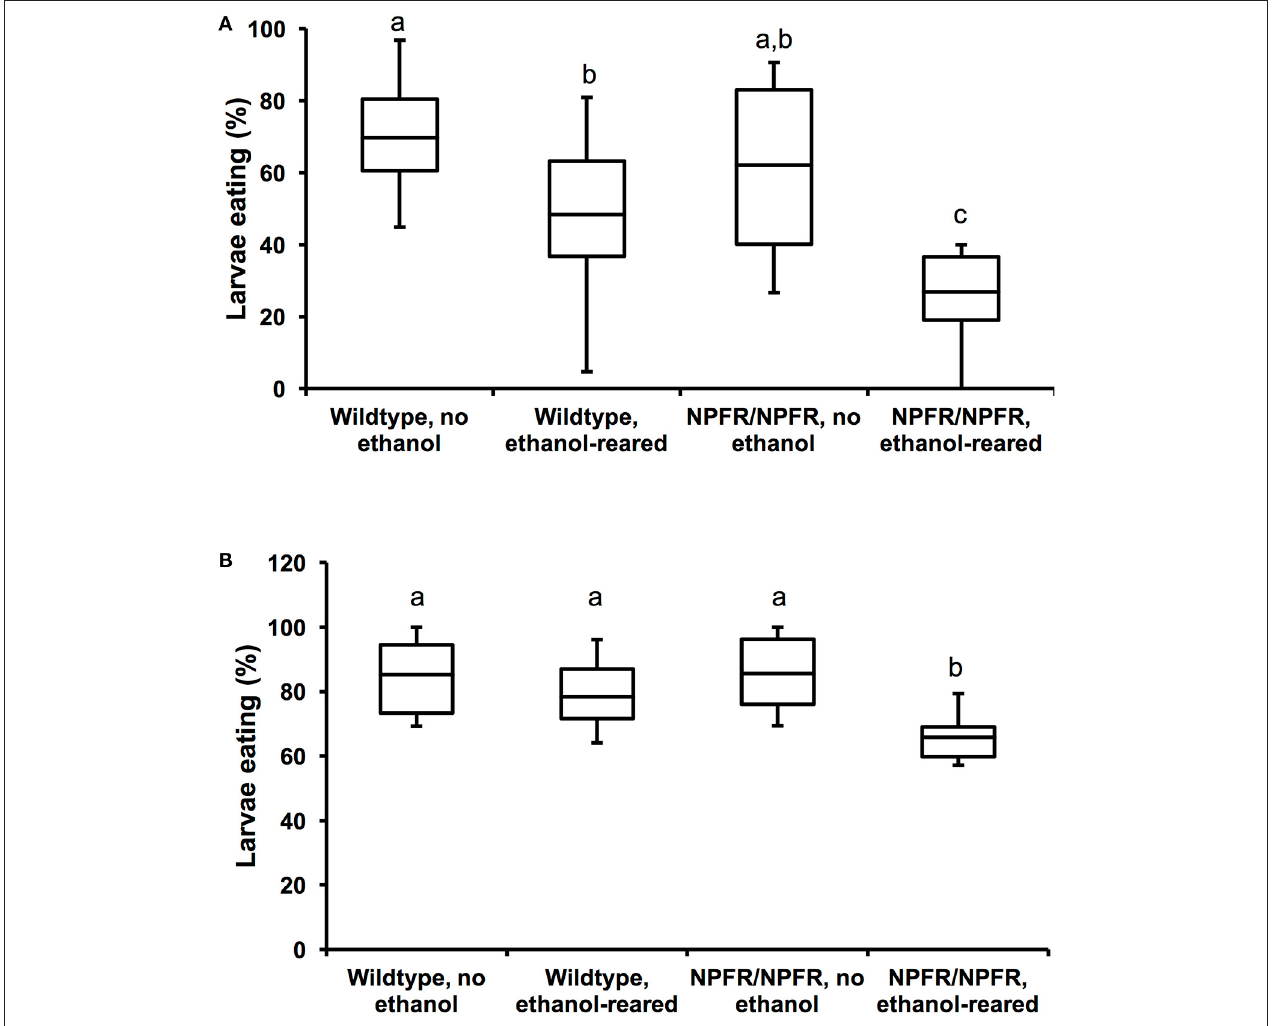
FIGURE 3 | Loss of NPF signaling enhances feeding deficits in ethanol-supplemented flies . (A) Percentage of unstarved first instar larvae that ate during a 20-min interval. Both ethanol-rearing and loss of npfr1 result in reduced feeding ( N = 12, 11, 11, 11, P < 0.001 for the effect of ethanol-rearing, P = 0.009 for the effect of mutation of npfr1, two-way ANOVA with Tukey’s post-hoc analysis). (B) Percentage of unstarved first instar larvae that ate during a 45-min interval. ( N = 10, 10, 12, 10, P = 0.003 for the effect of ethanol-rearing, P = 0.13 for the effect of npfr1 mutation, P = 0.046 for the interaction between ethanol and genotype, two-way ANOVA with Tukey’s post-hoc analysis). Center lines show the sample mean; box limits indicate the 25th and 75th percentiles as determined by R software; whiskers extend 1.5 times the interquartile range from the 25th and 75th percentiles. Boxes sharing the same letter do not differ significantly, while boxes with different letters are significantly different ( P <